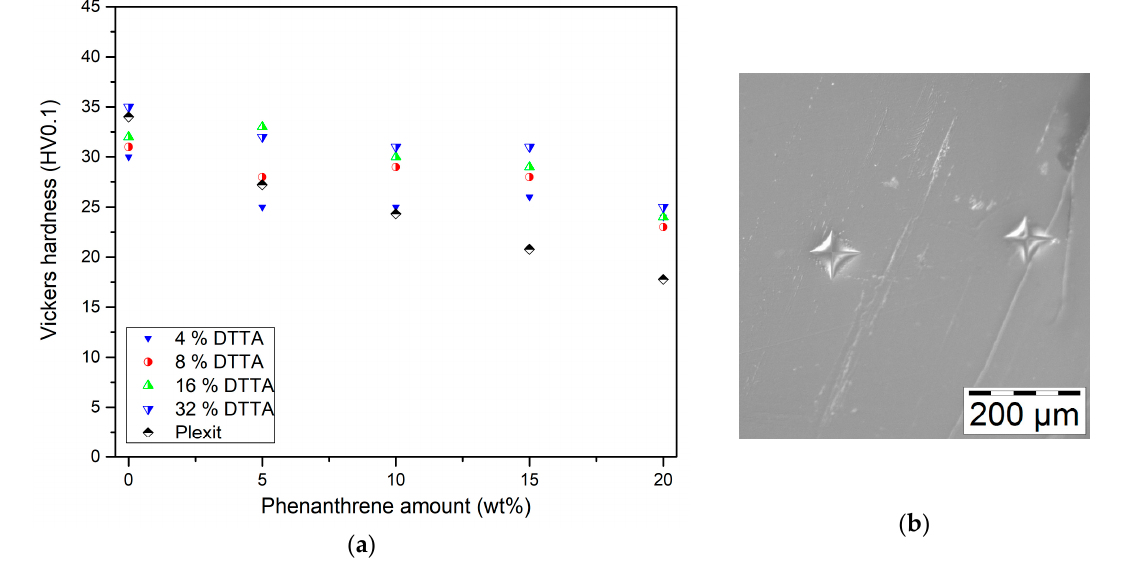
Figure 9. ( a ) Vickers hardness change as a function of DTTA and phenanthrene content; ( b ) Light microscope image of Vickers diamond tip indentation in a representative specimen (4% DTTA, 10% phenanthrene).